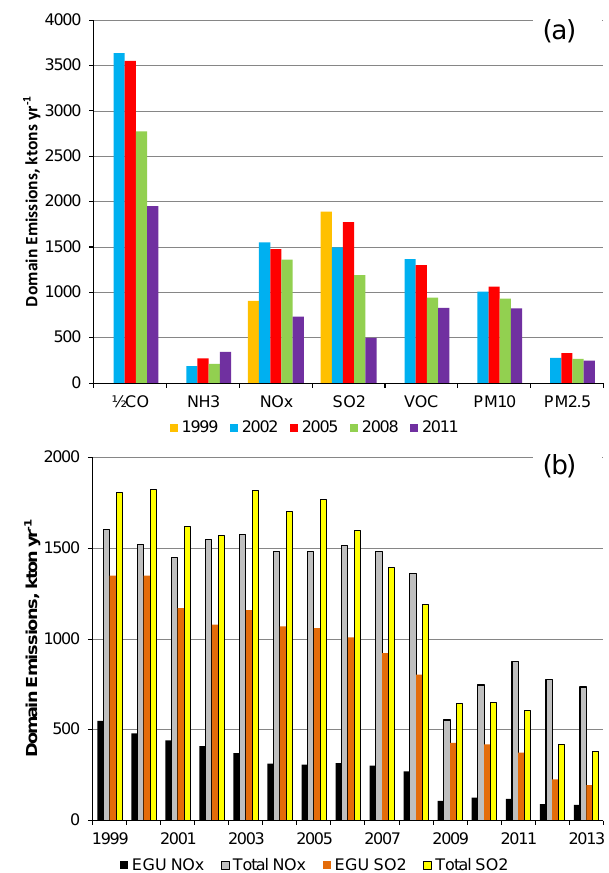
Figure 2. (a) NEI emissions by species within the Look Rock do- main for select years between 1999 and 2011 (data other than SO 2 and NO x were not considered reliable for 1999 and are not